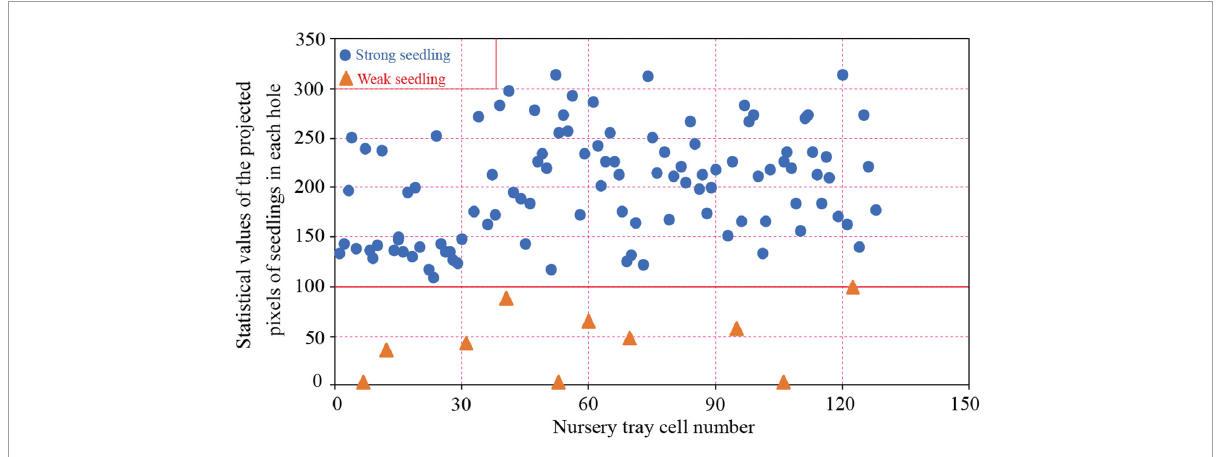
FIGURE5 Pixel statistical scatter plot of seedling leaf area.